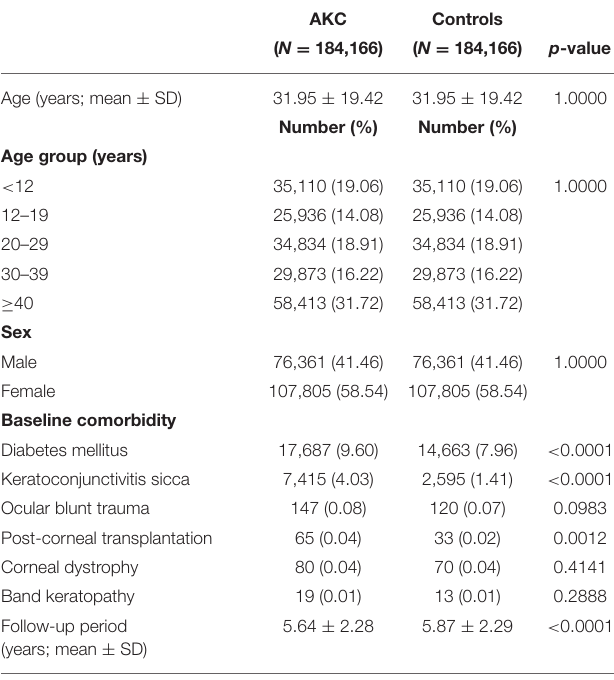
TABLE 1 | Comparison of the demographic characteristics and comorbidities between the atopic keratoconjunctivitis (AKC) and control